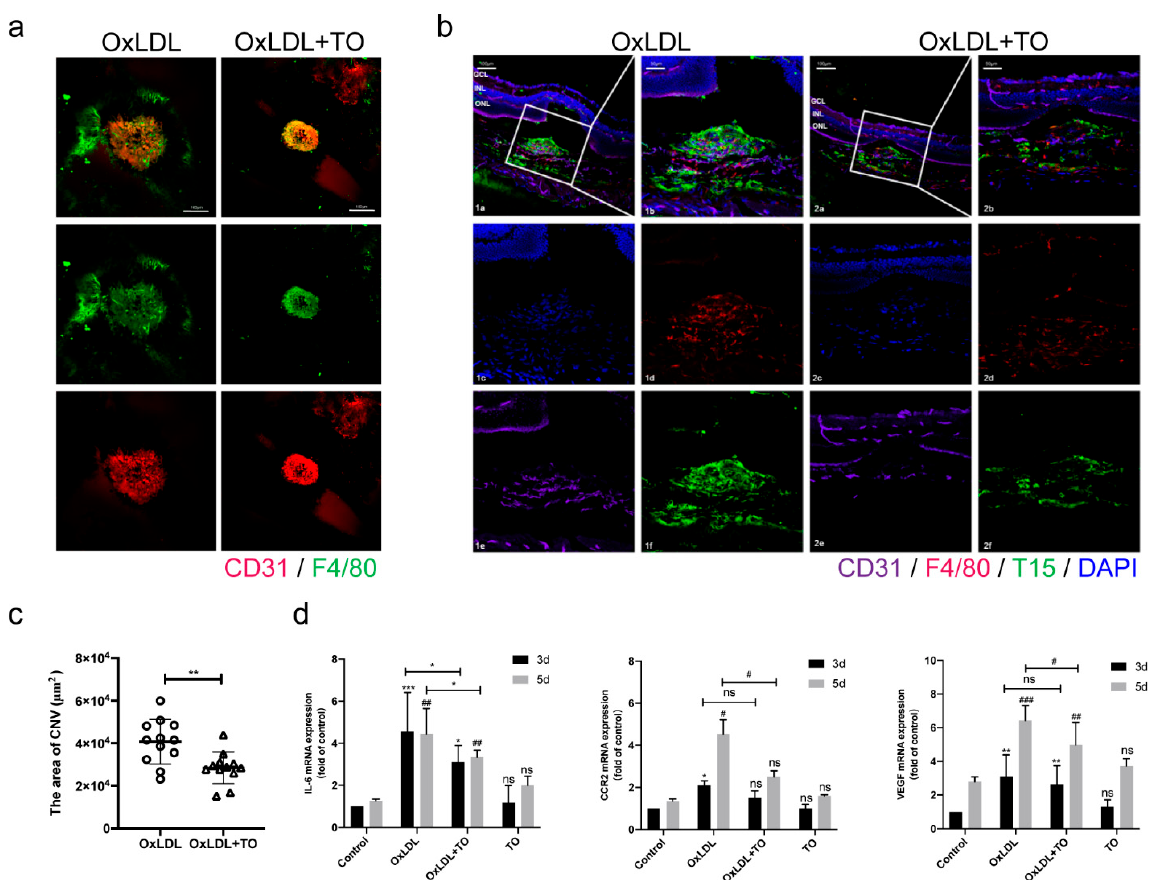
Figure 1. Effect of LXR agonist on OxLDL-induced experimental CNV. ( a ) Choroidal flat mount with immunofluorescence double labeling staining, CD31 labeled endothelial cell (red), F4/80 labeled macrophage (green), and DAPI labeled nuclear (blue), bars = 100 μ m ( b ) Frozen section with im- munofluorescence staining, CD31 labeled endothelial cell (purple), F4/80 labeled macrophage (red), T15-labeled LDL (green), and DAPI labeled nuclear (blue), bars = 100 µ m ( c ) Quantitative analysis of 2D lesion regions in CNV mice post laser processing in choroidal flat mounts. The lesion sizes were gauged with the ImageJ software. Values are presented by means ± SEM, n = 12, * p < 0.05, ** p < 0.01 vs. OxLDL group ( d ) IL-6, CCR2, and VEGF mRNA in choroidal tissue expression were detected via qRT-PCR. Data are expressed as the relative CNV lesion area ± SEM, n = 3, ns indicates p > 0.05, * p < 0.05, ** p < 0.01, *** p < 0.001 vs. 3 day control group, # p < 0.05, ## p < 0.01, ### p < 0.001